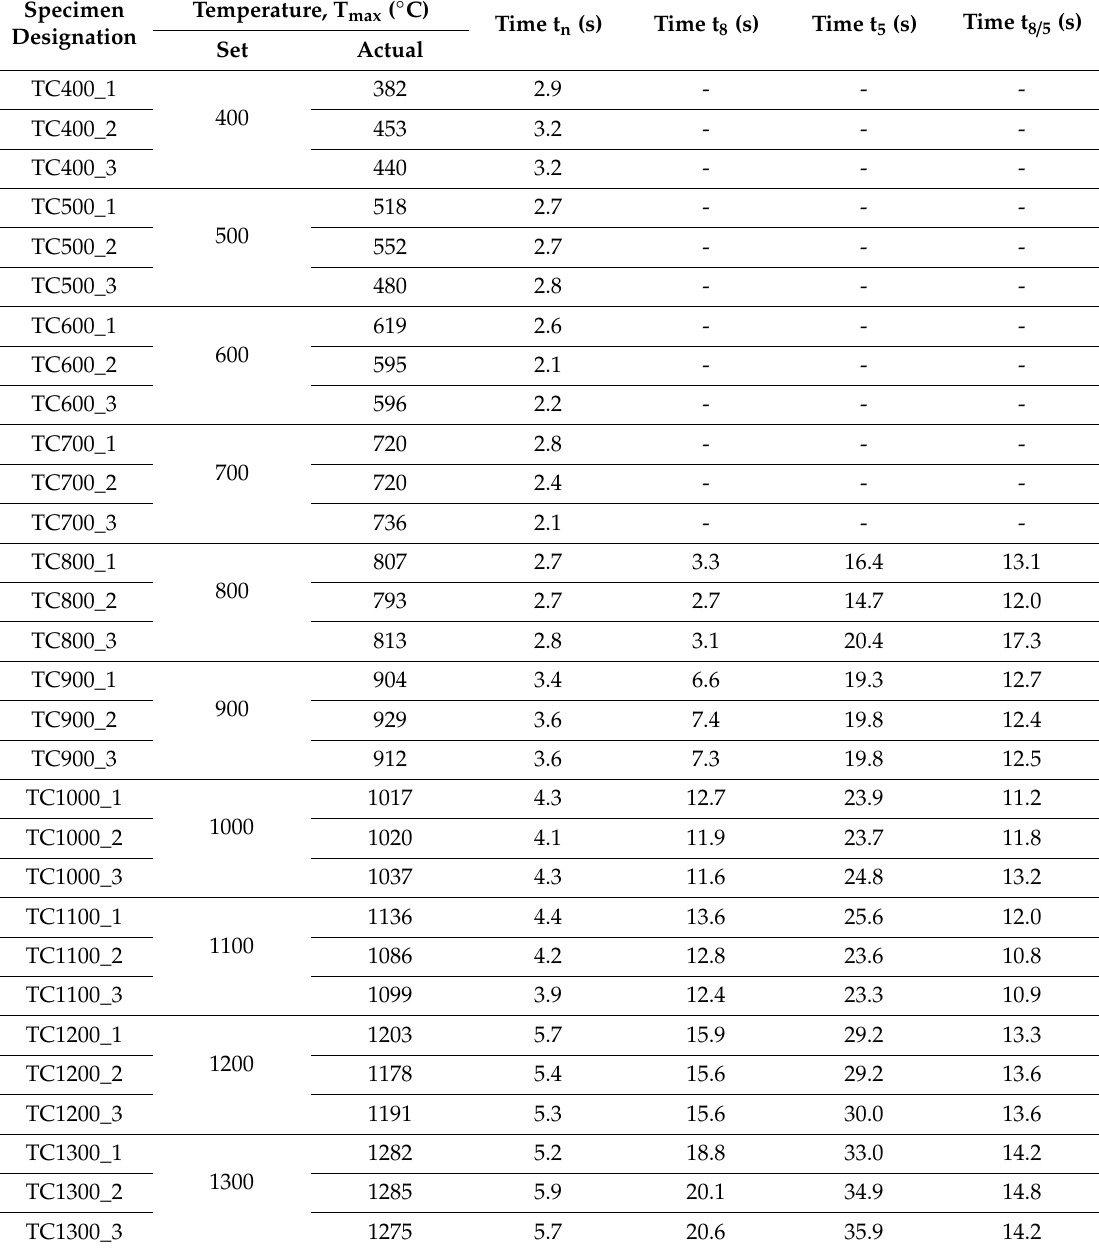
Table 3. Parameters of imposed thermal cycles with variable maximum